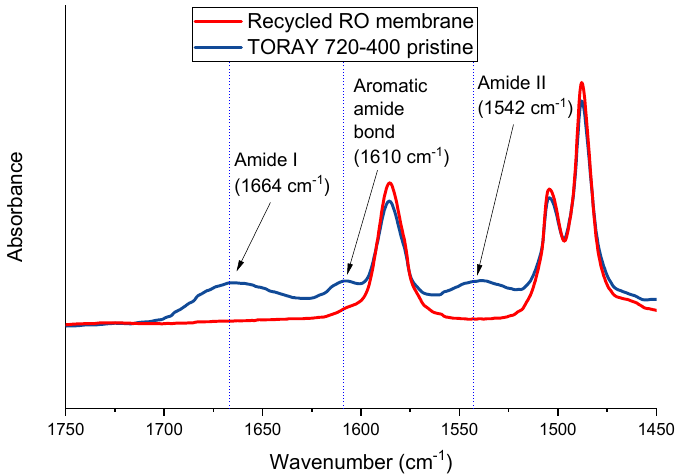
Figure 1. ATR-FTIR spectra of the recycled RO and TM720-400 pristine membranes.